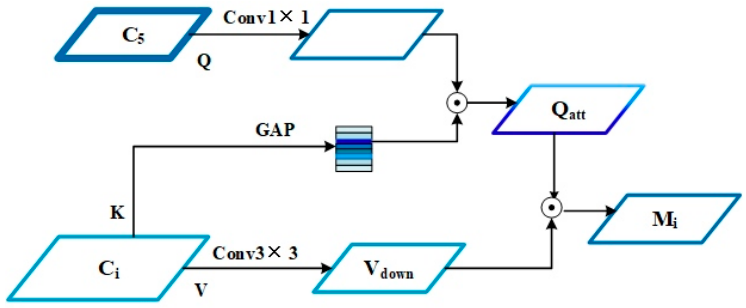
Figure 6. Illustration of High-level Guided Model (HGM).